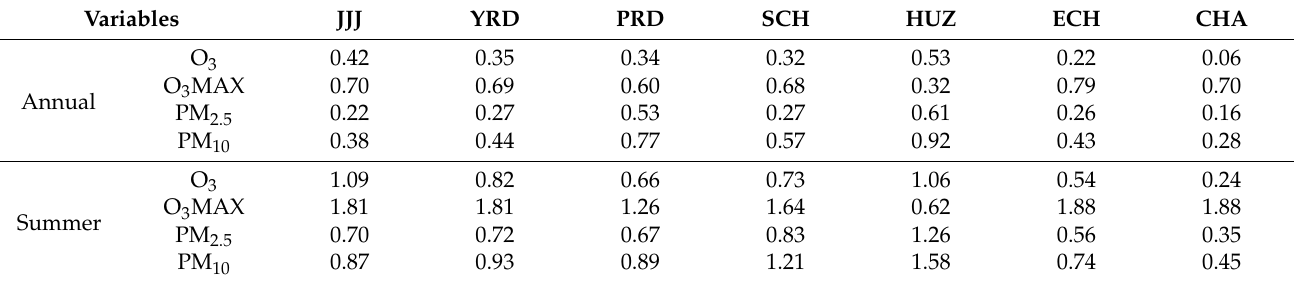
Table 6. Impact of land-use change on O 3 (unit: ppbv) and PM (unit: µ g m − 3 ) concentrations in typical regions under carbon